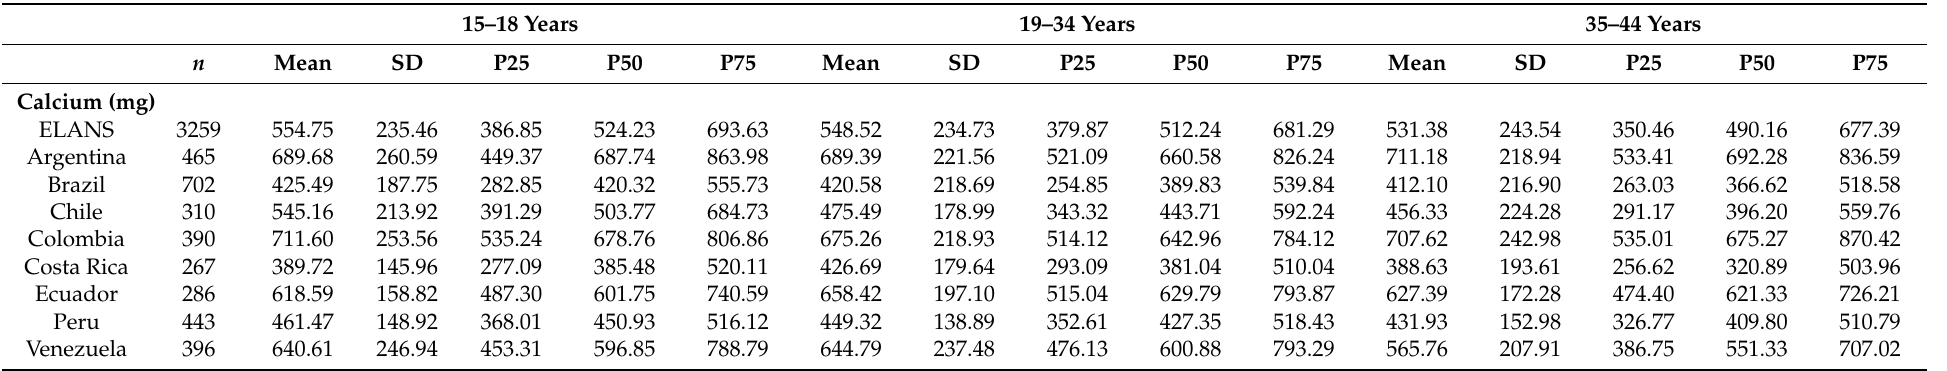
Table 5. Micronutrient intake by age group and country among childbearing-age women in the Latin American Study of Nutrition and Health (ELANS),